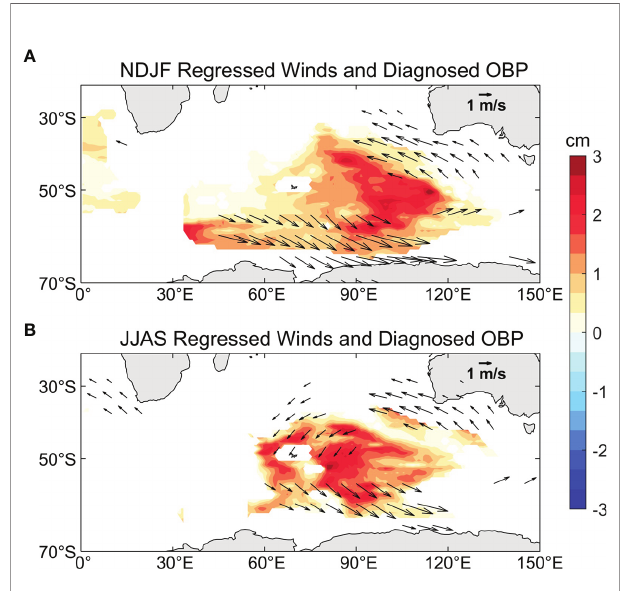
FIGURE 5 | Ocean bottom pressure nomalies from two idealized PCOM experiments forced by the (A) regression wind anomalies in Figure Figures 4A , (B) regression wind anomalies in Figures 4C .